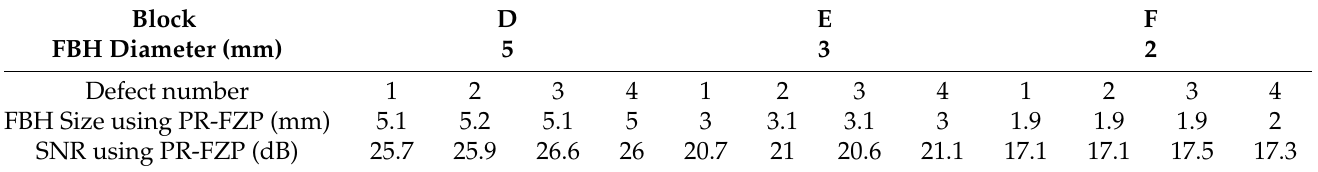
Table 3. Results of flaws size evaluation by using − 6 dB drop